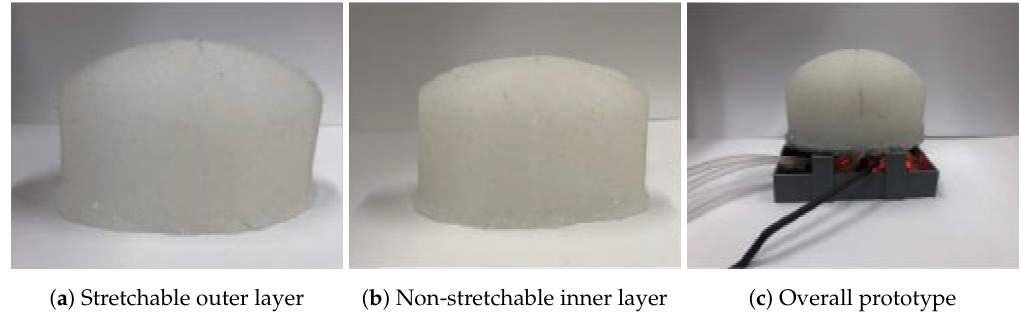
Figure 1. ( a , b ) The different layers of the haptic mouse. ( c ) The combined layers with a computer mouse circuit board in a 3D printed